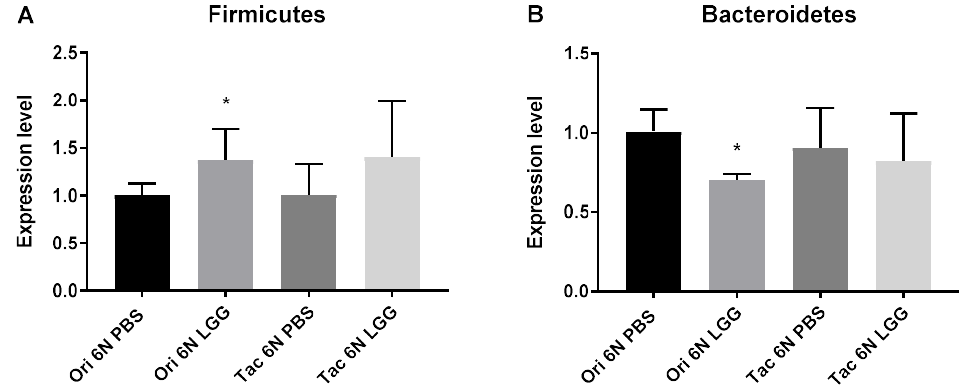
Figure 6. Modulation of fecal microbial composition by probiotic (LGG) administration, as compared to controls receiving PBS. Microbiota composition was measured through quantitative real-time PCR analysis. The expression level of both graphs was compared with the Universal bacterial primer (U1). The number of samples was 5–7. ( A ) Expression levels of Firmicutes in the Ori 6N and Tac 6N groups; ( B ) Expression levels of Bacteroidetes of the Ori 6N and Tac 6N groups. In the statistical analysis, Ori 6N LGG was compared with Ori 6N PBS, and Tac 6N LGG was compared with Tac 6N PBS. The data represent the means ± SD and were analyzed by Fisher’s LSD test compared to the corresponding PBS group. Significance is indicated when * p < 0.05.